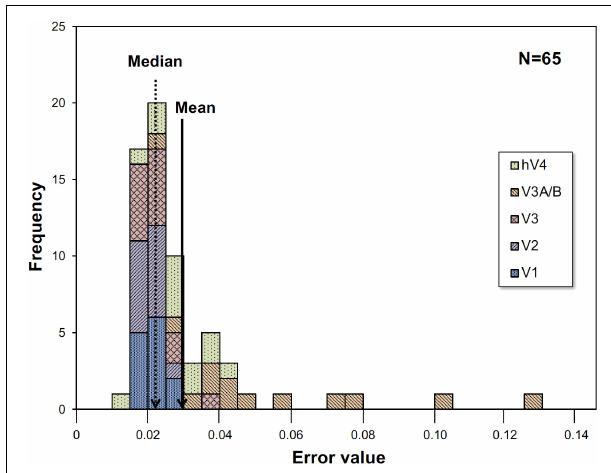
FIGURE 3 | Histogram of error value (EV). Histogram for all thirteen subjects and five visual cortices. EVs were large in V3A/B for some subjects.